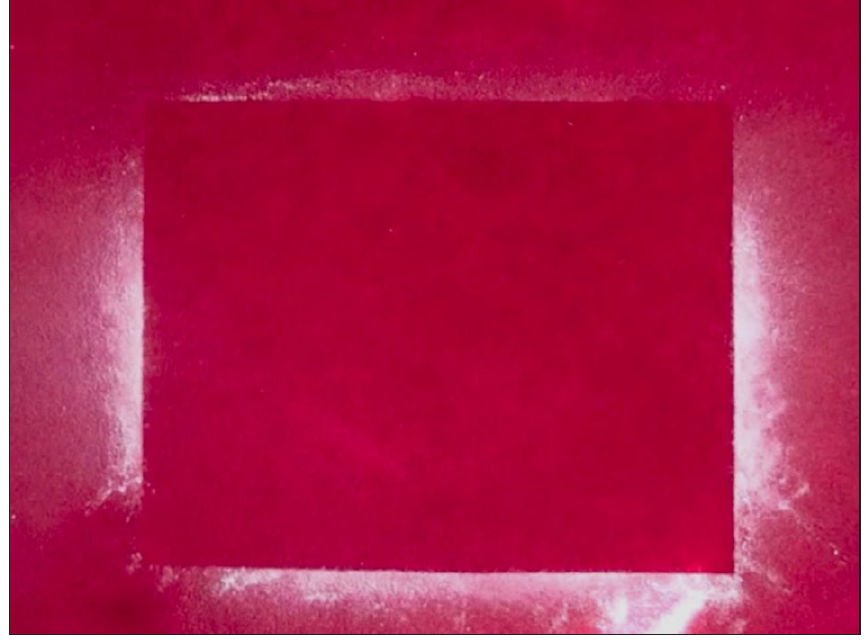
Figure 4: 50 things my son doesn’t need me for